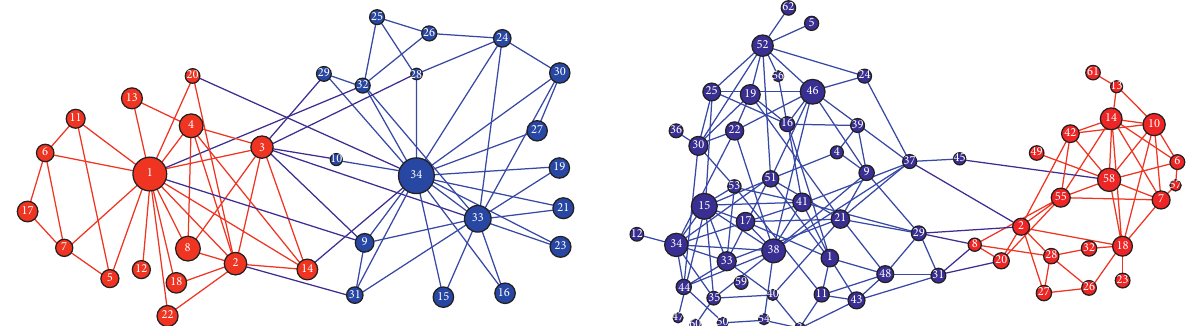
Figure 5: The balance factor of each node in the Karate Club and Dolphin databases.